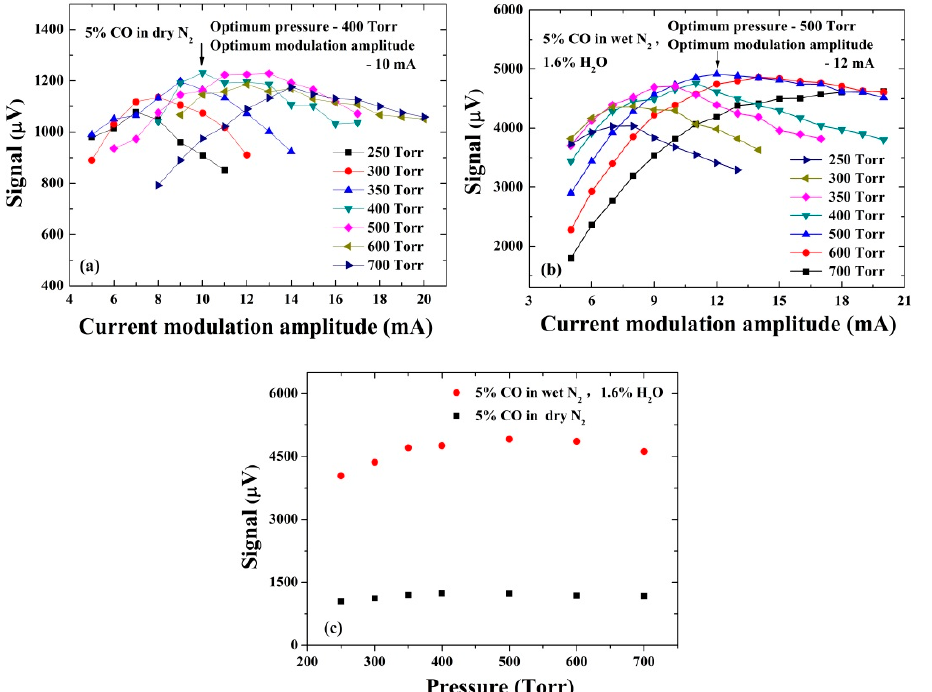
Figure 3. ( a , b ) 2 f QEPAS signal amplitudes obtained at different pressures and laser modulation amplitudes in dry and wet 5% CO/N 2 mixtures, respectively; ( c ) 2 f QEPAS signal amplitudes for optimum modulation amplitude at different gas pressures.